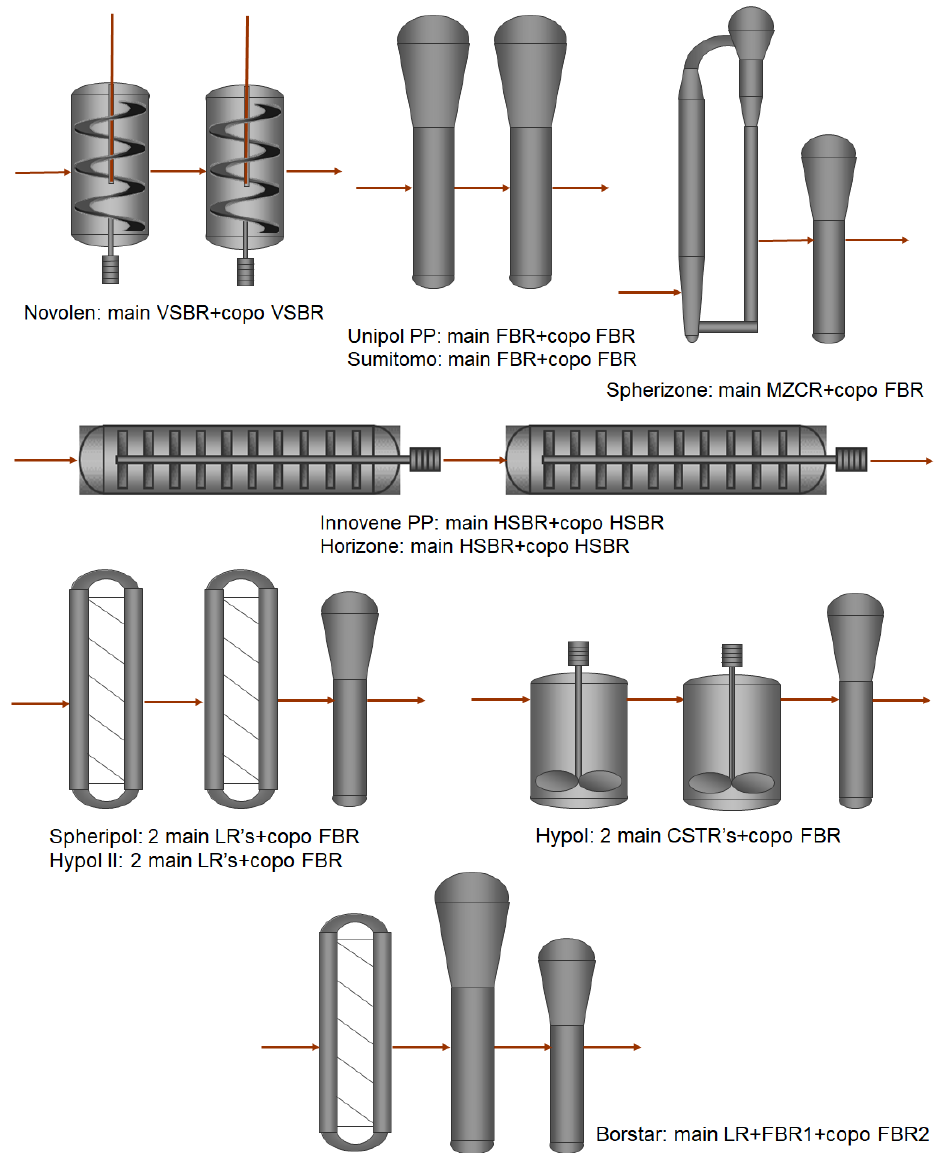
Figure 1. Generalized schemes of the modern polypropylene production processes.